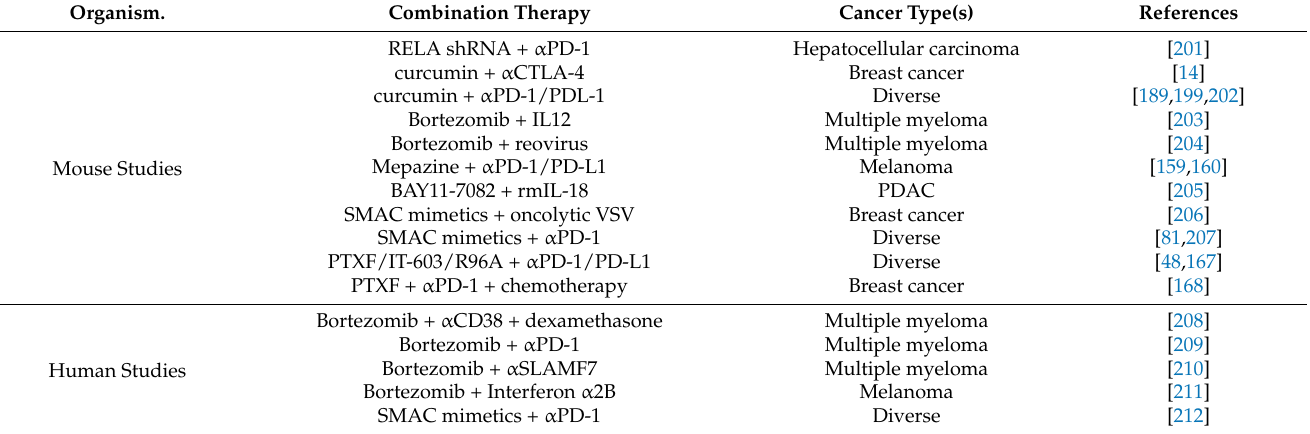
Table 2. Examples of combination of NF-kB inhibitors with other immunotherapies.